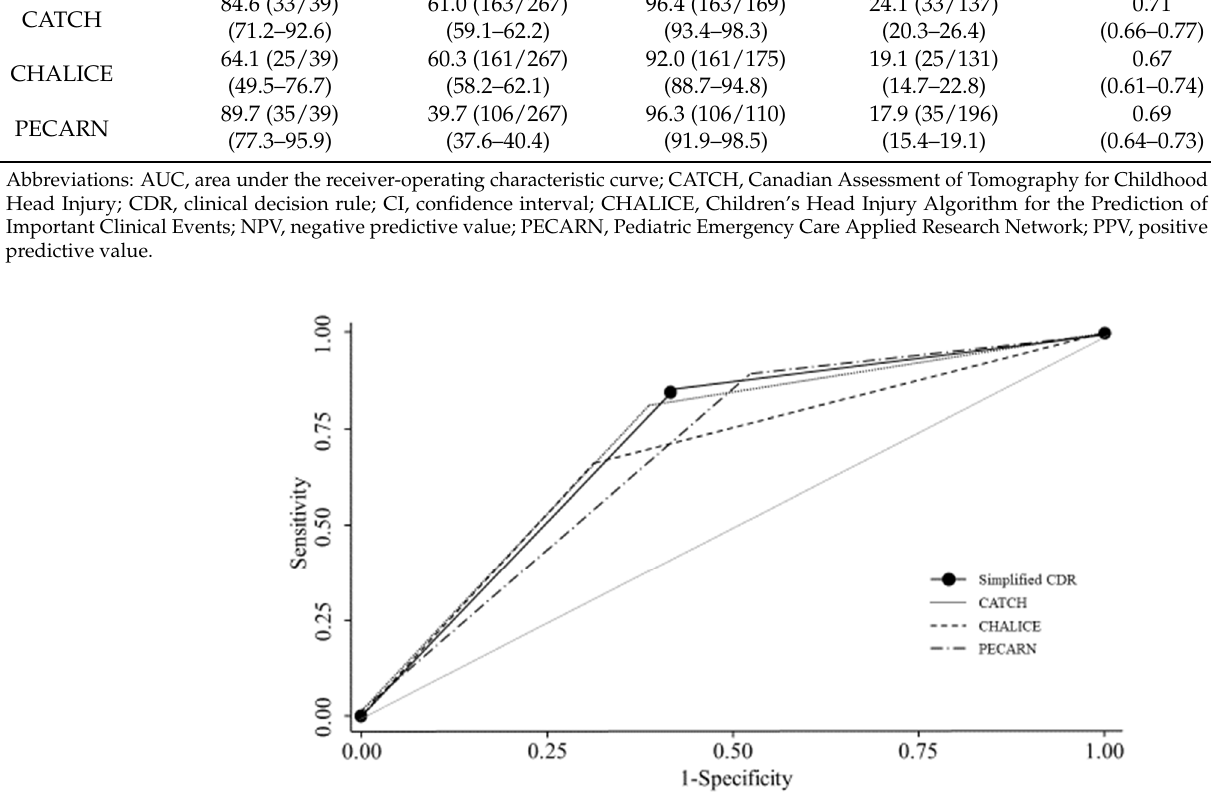
matic brain injury.